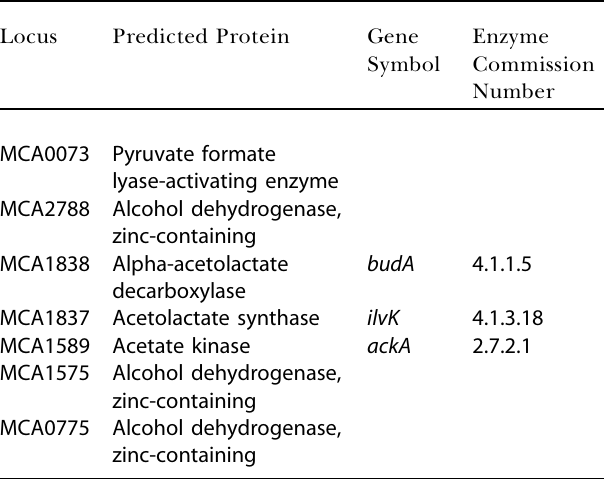
Table 3. Putative Enzymes Associated with